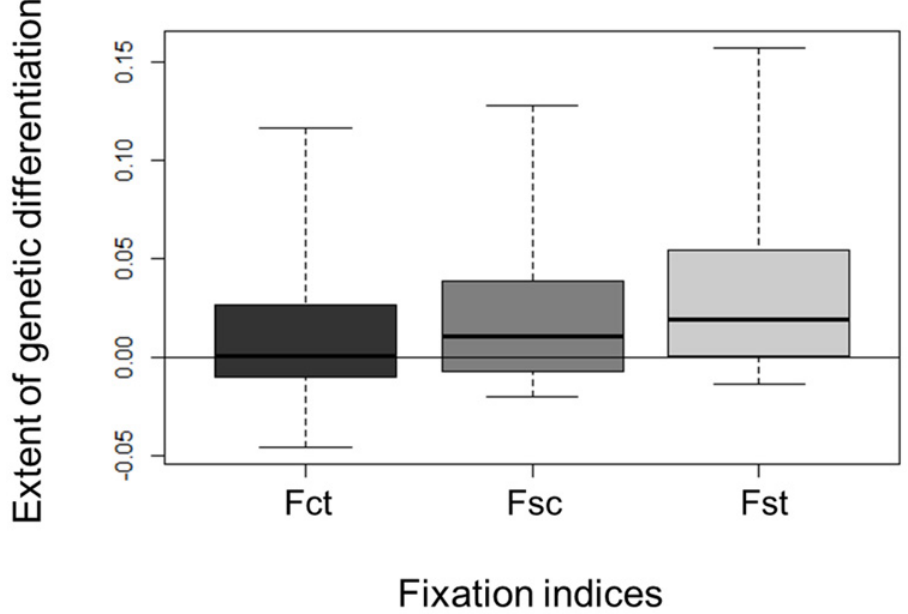
Fig 5. Box-plot of the distribution of single-locus fixation indices ( F CT , F SC and F ST ) estimated under the hierarchical model of population subdivision (boxes indicate 5%, 25%, 50%, 75% and 95% quantiles). F CT is the differentiation between sites relative to total, F SC is the differentiation between local habitats relative to sites, and F ST is the differentiation between local habitats relative to